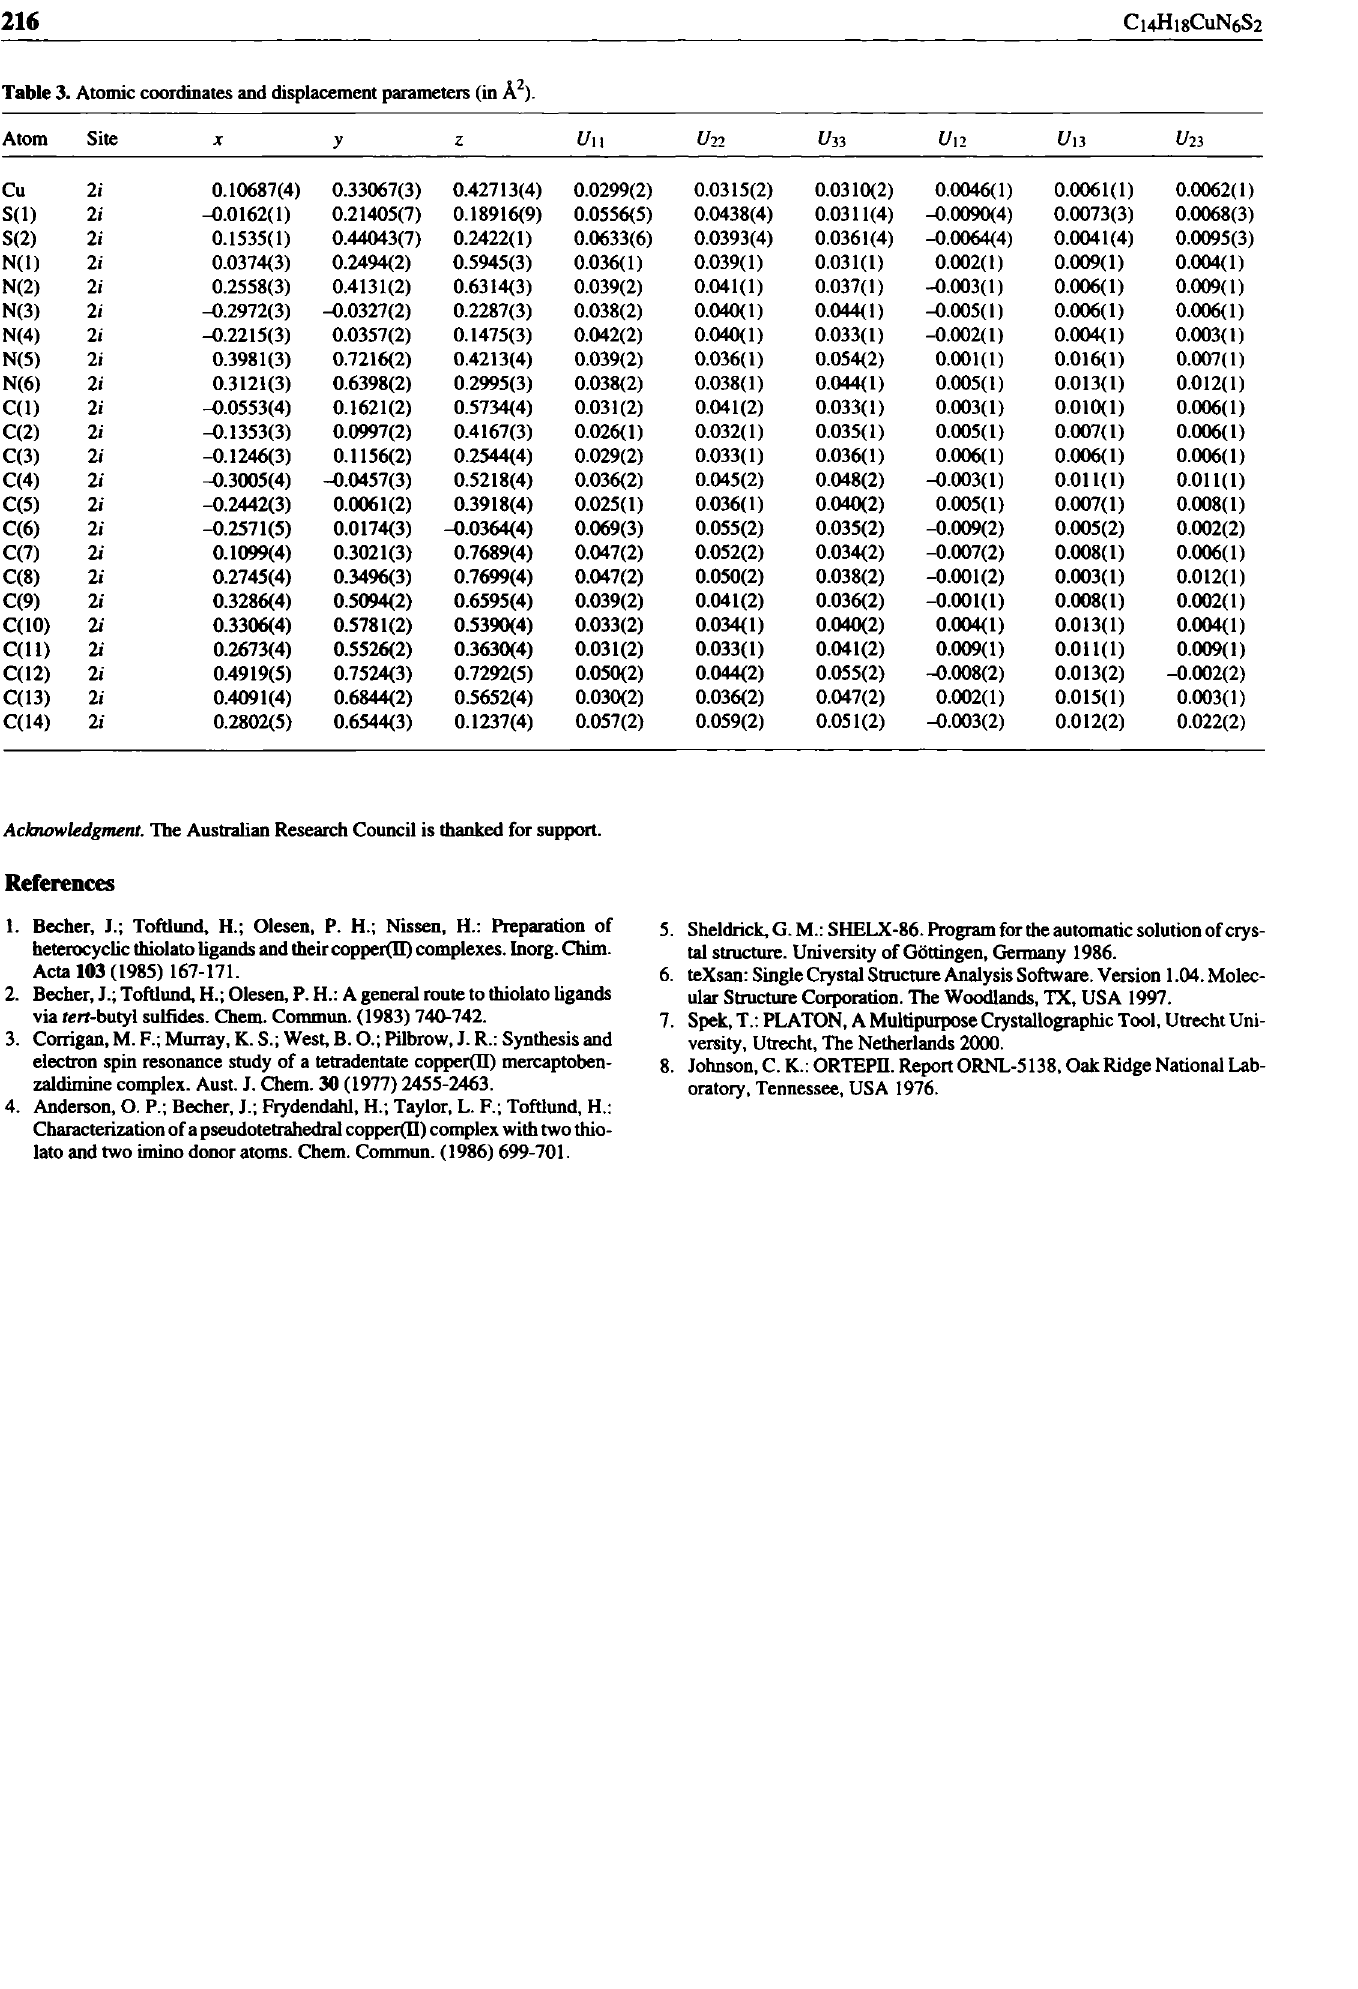
Table 3. Atomic coordinates and displacement parameters (in Ä 2